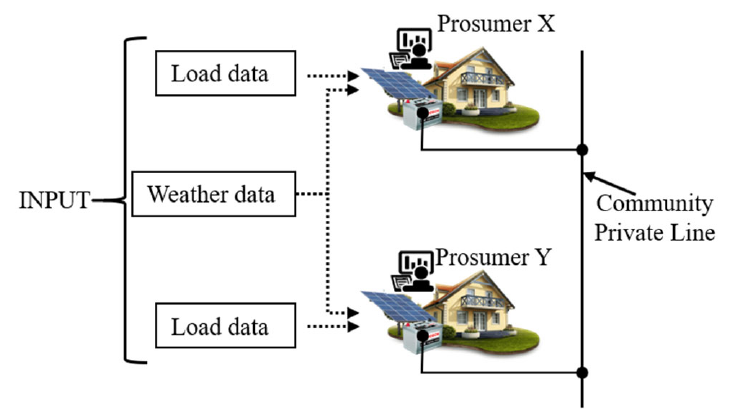
Figure 7. Simulation setup.